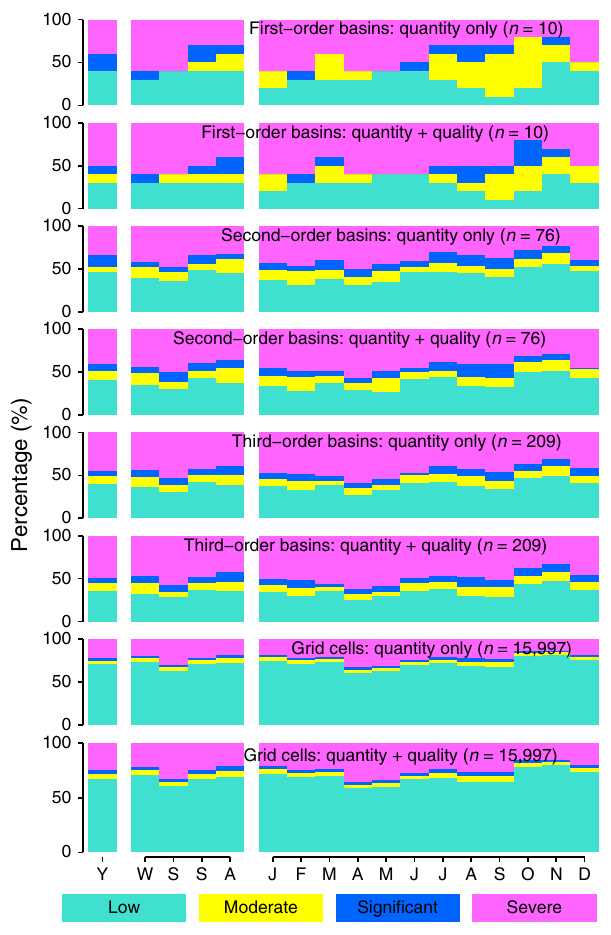
Fig. 3 The proportions of regions under various water scarcity levels. Estimates were made across four different geographic scales at three temporal scales (Y, yearly; W – A, seasonal from winter throughout autumn; and J – D, monthly from January throughout December. Winter corresponds the months from December to February). The level of water scarcity is de fi ned in Methods section. Source data are provided as a Source Data fi